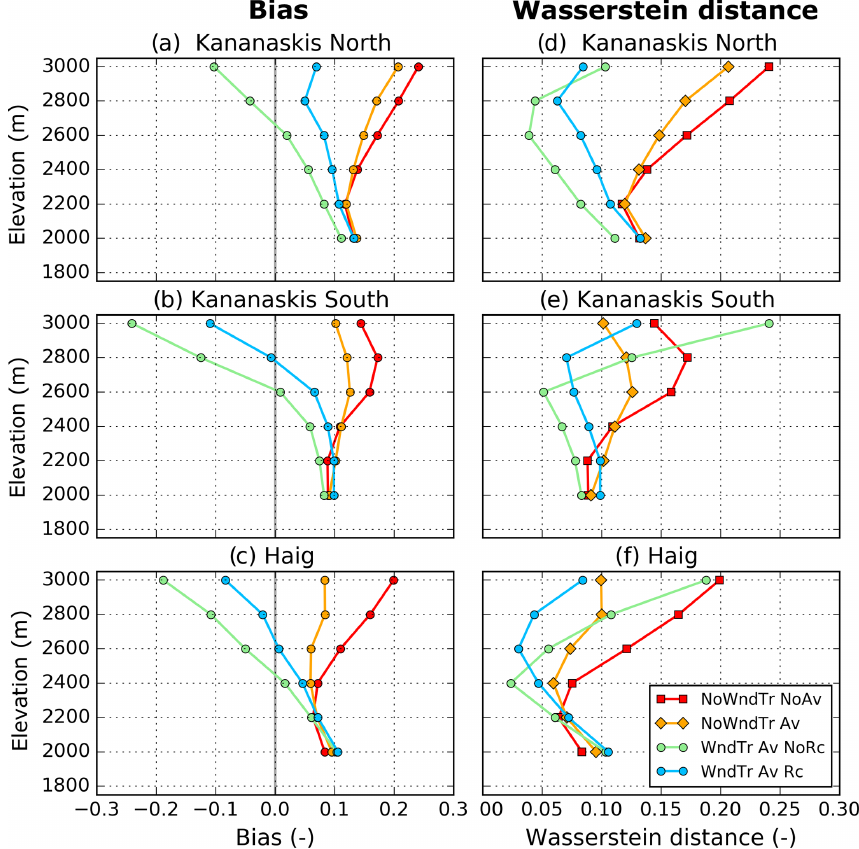
Figure 11. Bias and Wasserstein distance between observed and simulated snow persistence index as a function of elevation for four CHM experiments and three sub-regions. The location of these sub-regions is shown in Fig.